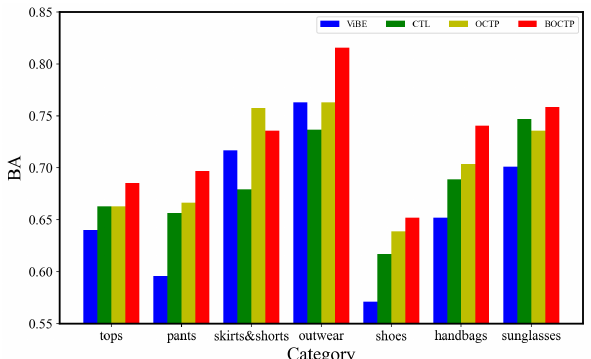
Figure 12. Binary Accuracy (BA) per category on STL-Fashion dataset for the label-given